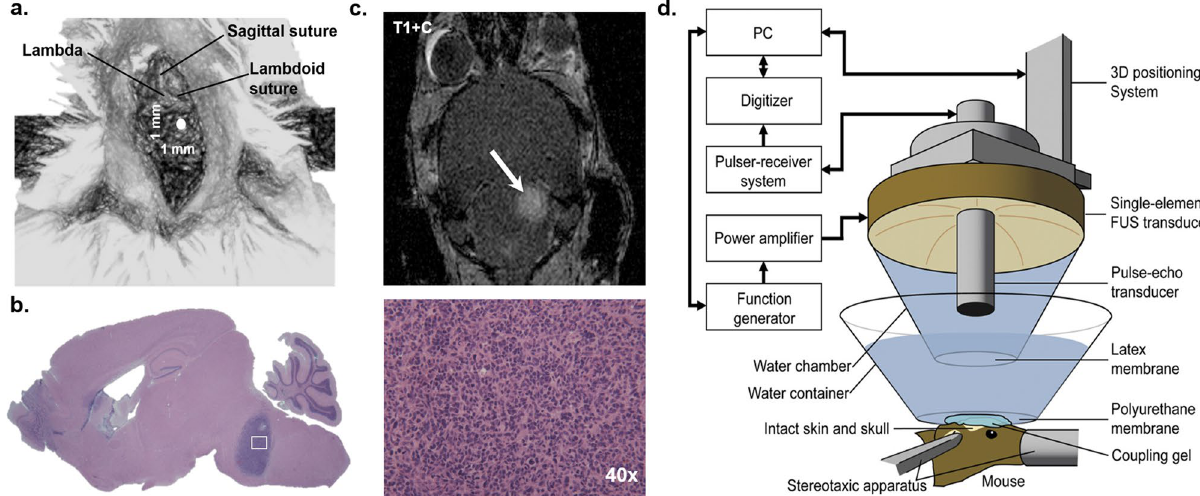
Figure 1. Tumor implantation and experimental setup ( a ) Skull coordinates for intra-pontine tumor implantation. Injections were made 1 mm lateral and 1 mm caudal to the lambda, and 6 mm deep to the skull. ( b ) On H&E, the tumor exhibited hypercellularity and mitotic figures consistent with high-grade glioma. ( c ) Tumor growth was confirmed on contrast-enhanced T1-weighted MR imaging. ( d ) Experimental setup for FUS-mediated BBB